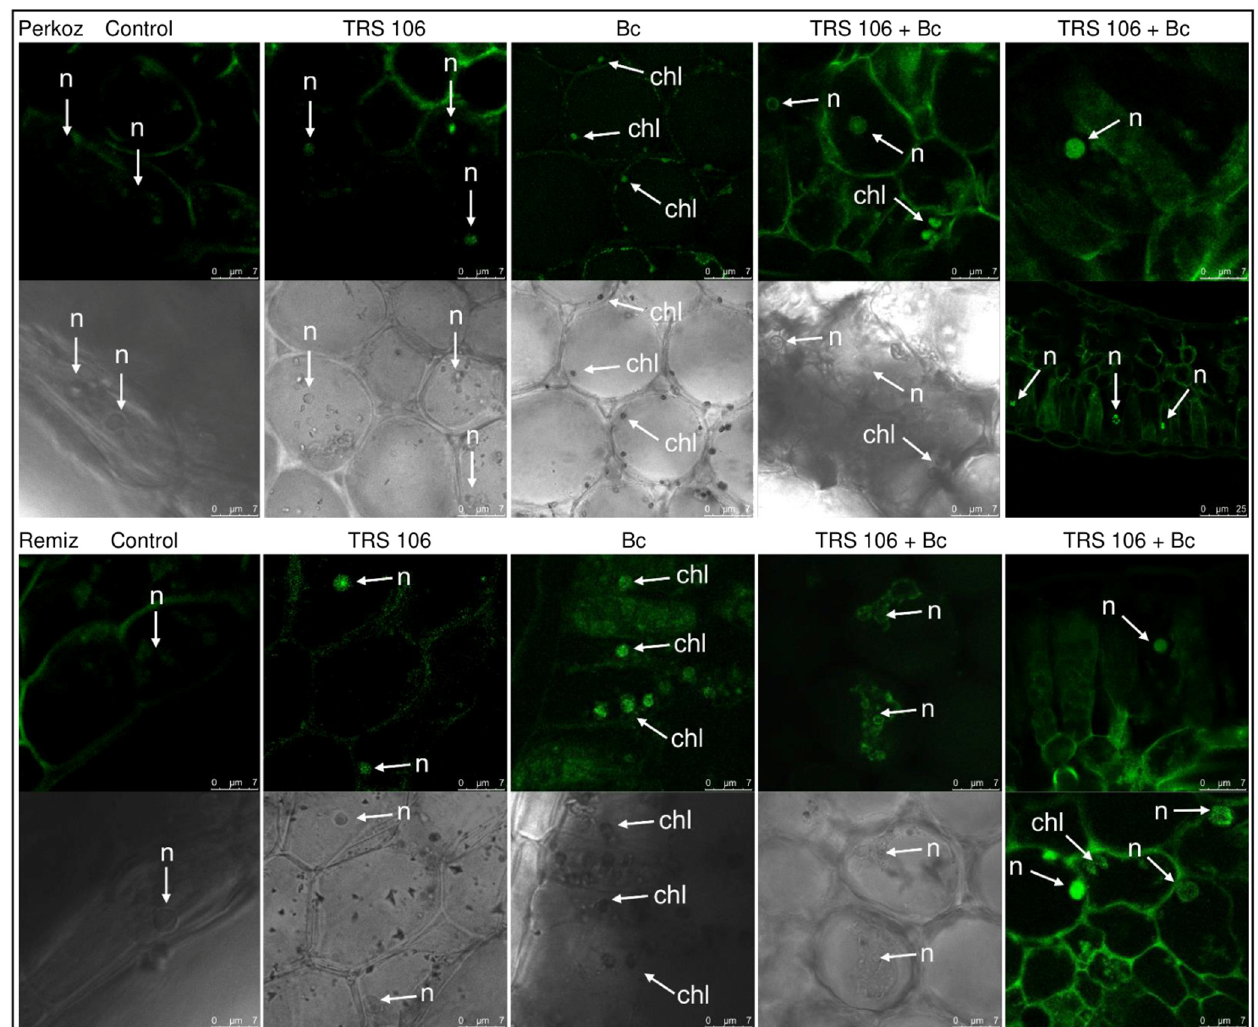
Figure 6. Subcellular visualizations of nitric oxide (NO) in cross sections of tomato leaves. Fluorescent confocal microscopy was used to detect NO localization in the parenchyma and in palisade and spongy mesophyll. Depending on the variant, the green fluorescence of NO was observed in the apoplast, chloroplast (chl), and nucleus (n). DAF-2DA was used for histochemical visualization of NO. As a negative control, leaf pieces were immersed in a buffer containing cPTIO which eliminates NO (Figure S1). The monochrome images are added to confirm and facilitate the localization of the organelle. Abbreviations are as in Figure